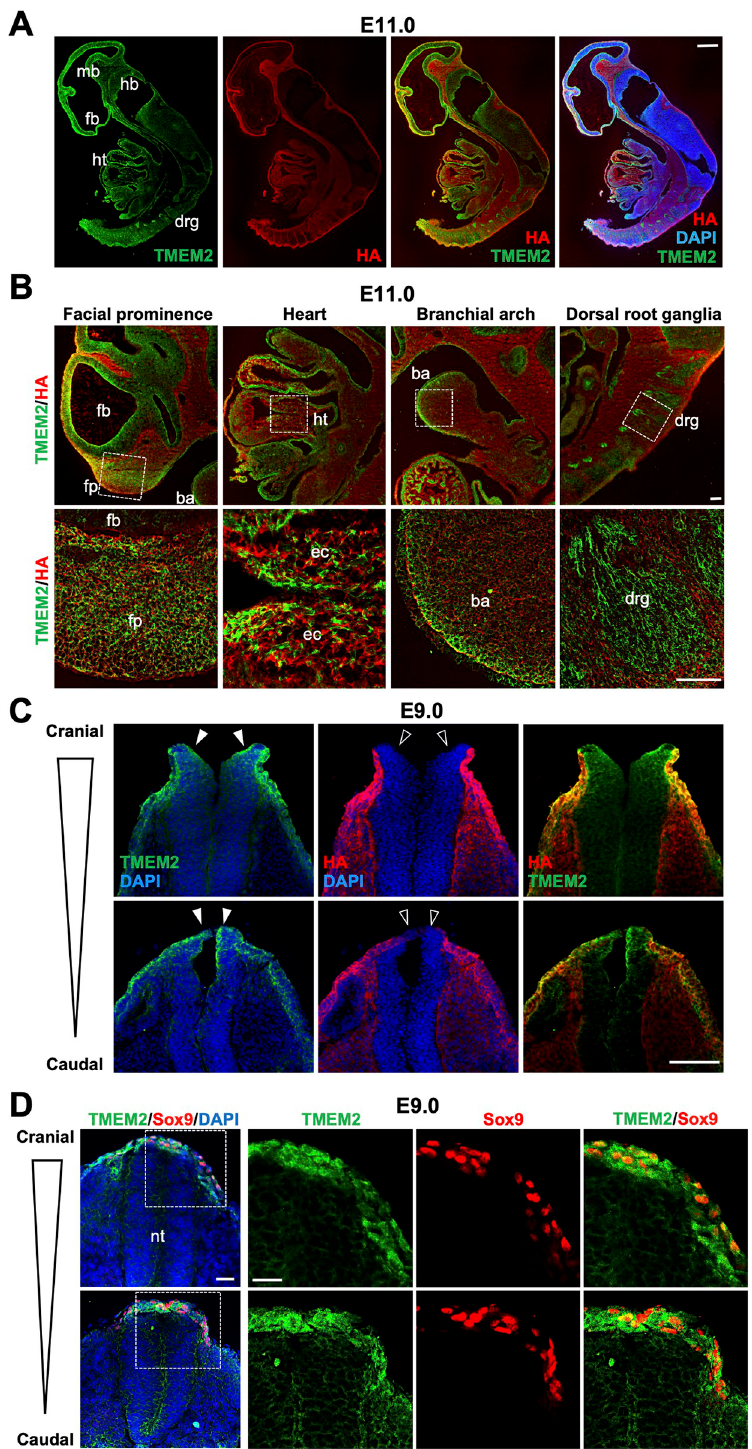
Fig 2. Expression of TMEM2 relative to HA distribution in the mouse embryo. ( A ) Sagittal sections of Tmem2-FLAG KI reporter embryos at E11.0 were double-labeled with anti-FLAG antibody and bHABP. Nuclei were counterstained with DAPI. fb , forebrain; mb , midbrain; hb , hindbrain; ht , heart; drg , dorsal root ganglia. ( B ) High magnification images of the facial prominence, heart, branchial arch, and dorsal root ganglion in Tmem2-FLAG KI embryos at E11.0 double-labeled for TMEM2-FLAG protein and HA. Areas indicated by boxes are enlarged in lower